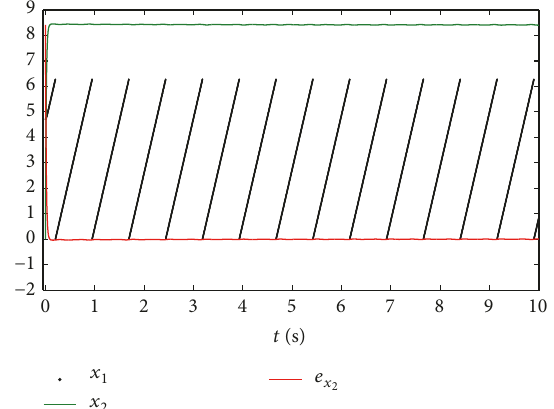
Figure 13: Double-cylinder with PD control by position and constant velocity ( 𝑥 2∗ = 8.415 rad/s = 10km/h).